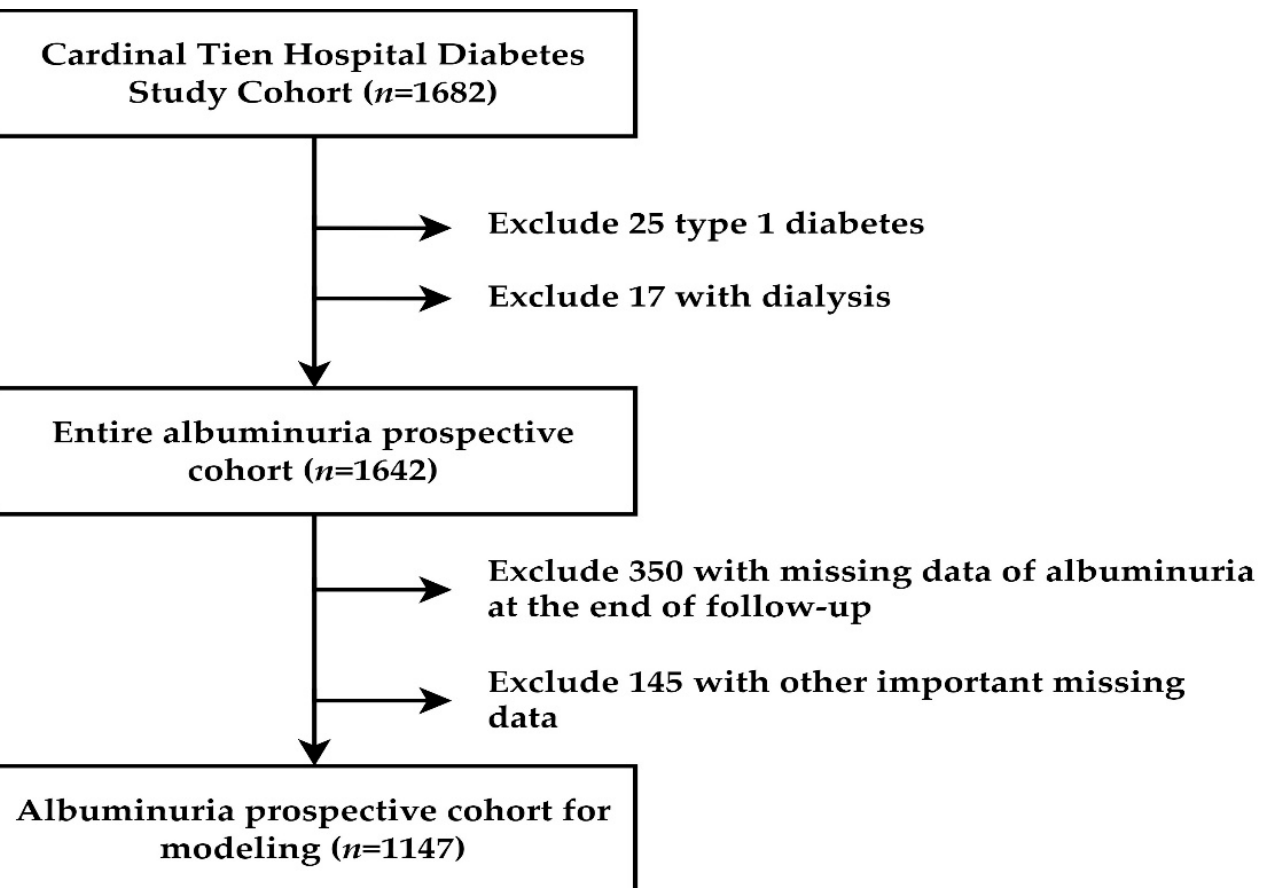
Figure 1. Flowchart of sample selection from the Cardinal Tien Hospital Diabetes Study Cohort. As previously published, the procedures for collecting demographic and biochemical data are as follows [18]. After fasting for 10 h, blood samples were collected for biochemical analyses. Plasma was separated from the blood within 1 h of collection and stored at 30 ◦ C until the analysis of fasting plasma glucose (FPG) and lipid profiles. FPG was measured using the glucose oxidase method (YSI 203 glucose analyzer; Yellow Springs Instruments, Yellow Springs, OH, USA). The total cholesterol and triglyceride (TG) levels were measured using the dry multilayer analytical slide method with a Fuji Dri-Chem 3000 analyzer (Fuji Photo Film, Tokyo, Japan). The serum high-density lipoprotein cholesterol (HDL-C) and low-density lipoprotein cholesterol (LDL-C) concentrations were analyzed using an enzymatic cholesterol assay, following dextran sulfate precipitation. A Beckman Coulter AU 5800 biochemical analyzer was used to determine the urine ACR by turbidimetry. Table 1 lists the definitions of the 15 baseline clinical variables (independent variables, sex, age, BMI, duration of diabetes, smoking, alcohol use, FPG, glycated hemoglobin, triglyceride, HDL-C, LDL-C, alanine aminotransferase, creatinine (Cr), SBP, and DBP) used in this study. The uACR at the end of the follow-up was a numerical variable, which was used as a dependent (target) variable, while the remaining 15 variables were used as predictor variables in this